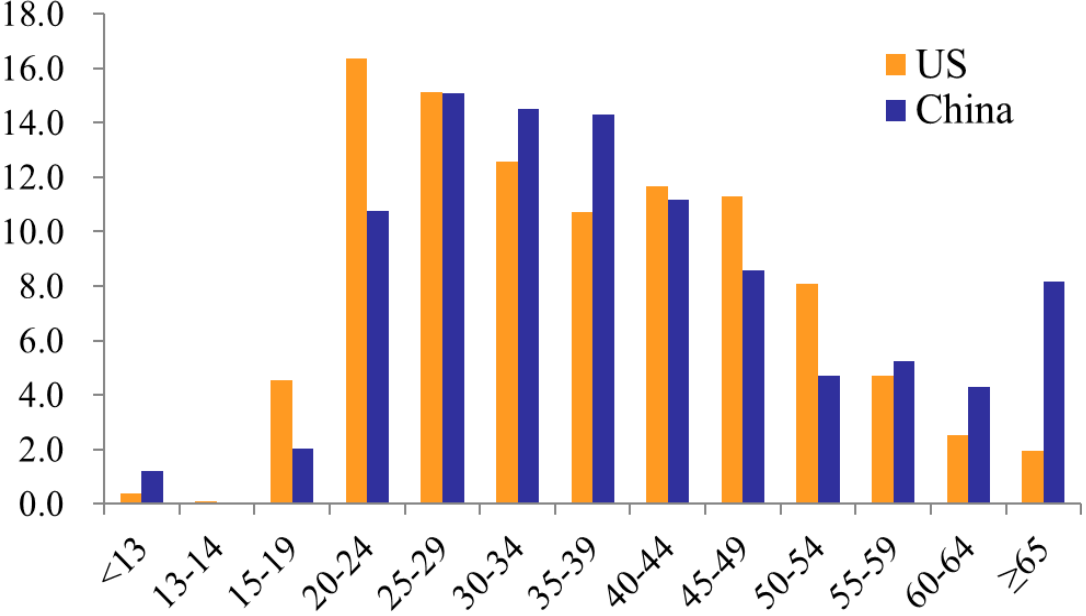
Figure 3. Comparison of distribution of HIV cases by age, 2011, United States and China. Source: [3,5].